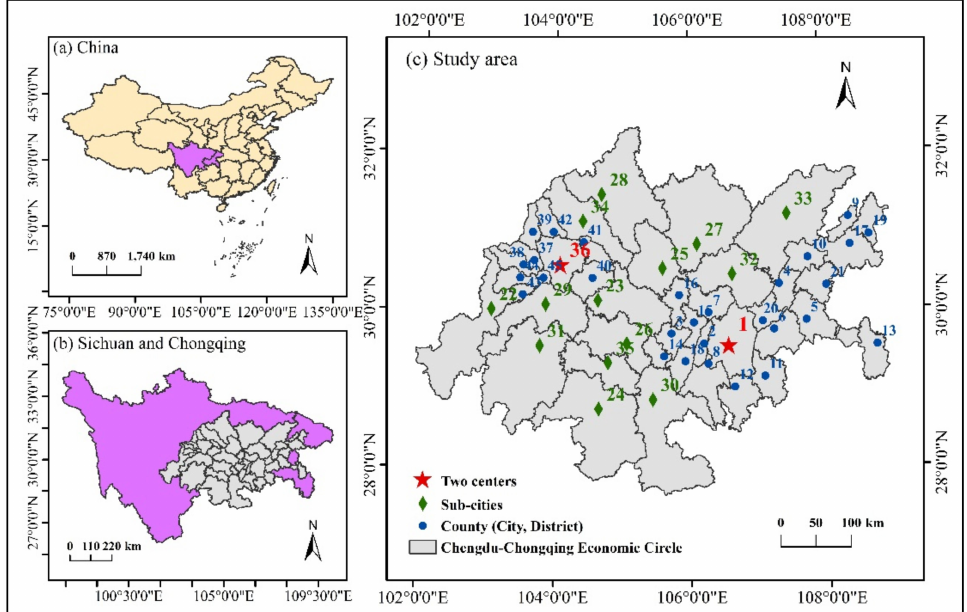
Figure 1. The study area. ( a ) Map of China, ( b ) map of Sichuan and Chongqing, ( c ) map of study area: 1 is the central urban area of Chongqing; 2 is Bishan; 3 is Dazu; 4 is Dianjiang; 5 is Fengdu; 6 is Fuling; 7 is Hechuan; 8 is Jiangjin; 9 is Kaizhou; 10 is Liangping; 11 is Nanchuan; 12 is Qijiang; 13 is Qianjiang; 14 is Rongchang; 15 is Tongliang; 16 is Tongnan; 17 is Wanzhou; 18 is Yongchuan; 19 is Yunyang; 20 is Changshou; 21 is Zhongxian; 22 is Ya’an; 23 is Ziyang; 24 is Yibin; 25 is Suining; 26 is Neijiang; 27 is Nanchong; 28 is Mianyang; 29 is Meishan; 30 is Luzhou; 31 is Leshan; 32 is Guang’an; 33 is Dazhou; 34 is Deyang; 35 is Zigong; 36 is the central urban area of Chengdu; 37 is Chongzhou; 38 is Dayi; 39 is Dujiangyan; 40 is Jianyang; 41 is Jintang; 42 is Pengzhou; 43 is Pujiang; 44 is Qionglai; 45 is